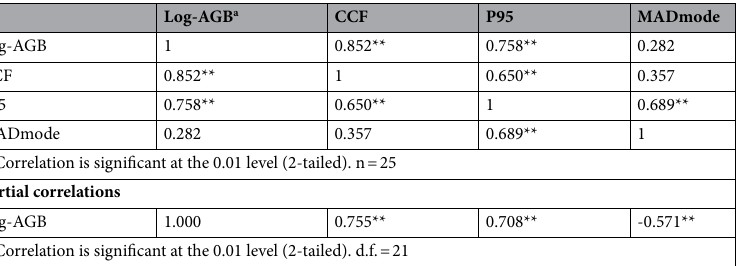
Table 11 . The Pearson’s correlation among the predictors and dependent variable of the selected Model— Model II 10 m radius plot. a AGB was positively associated with canopy cover (CCF) and 95th height percentile (P95). The insignificant positive relationship with MAD mode with log-AGB due to its strong correlation with P95; as indicated by the significant negative partial correlations between Log-AGB and MAD